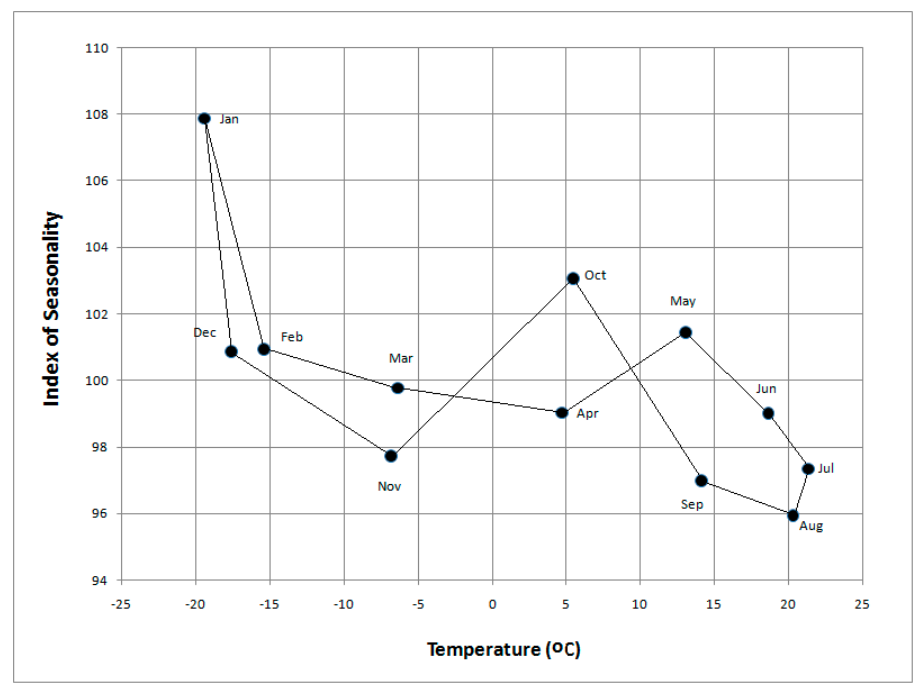
Figure 3. Monthly Index of Seasonality (IS) for Khabarovsk over the period 2000–2012 based on mean daily all-cause mortality for all age groups versus mean monthly temperature.